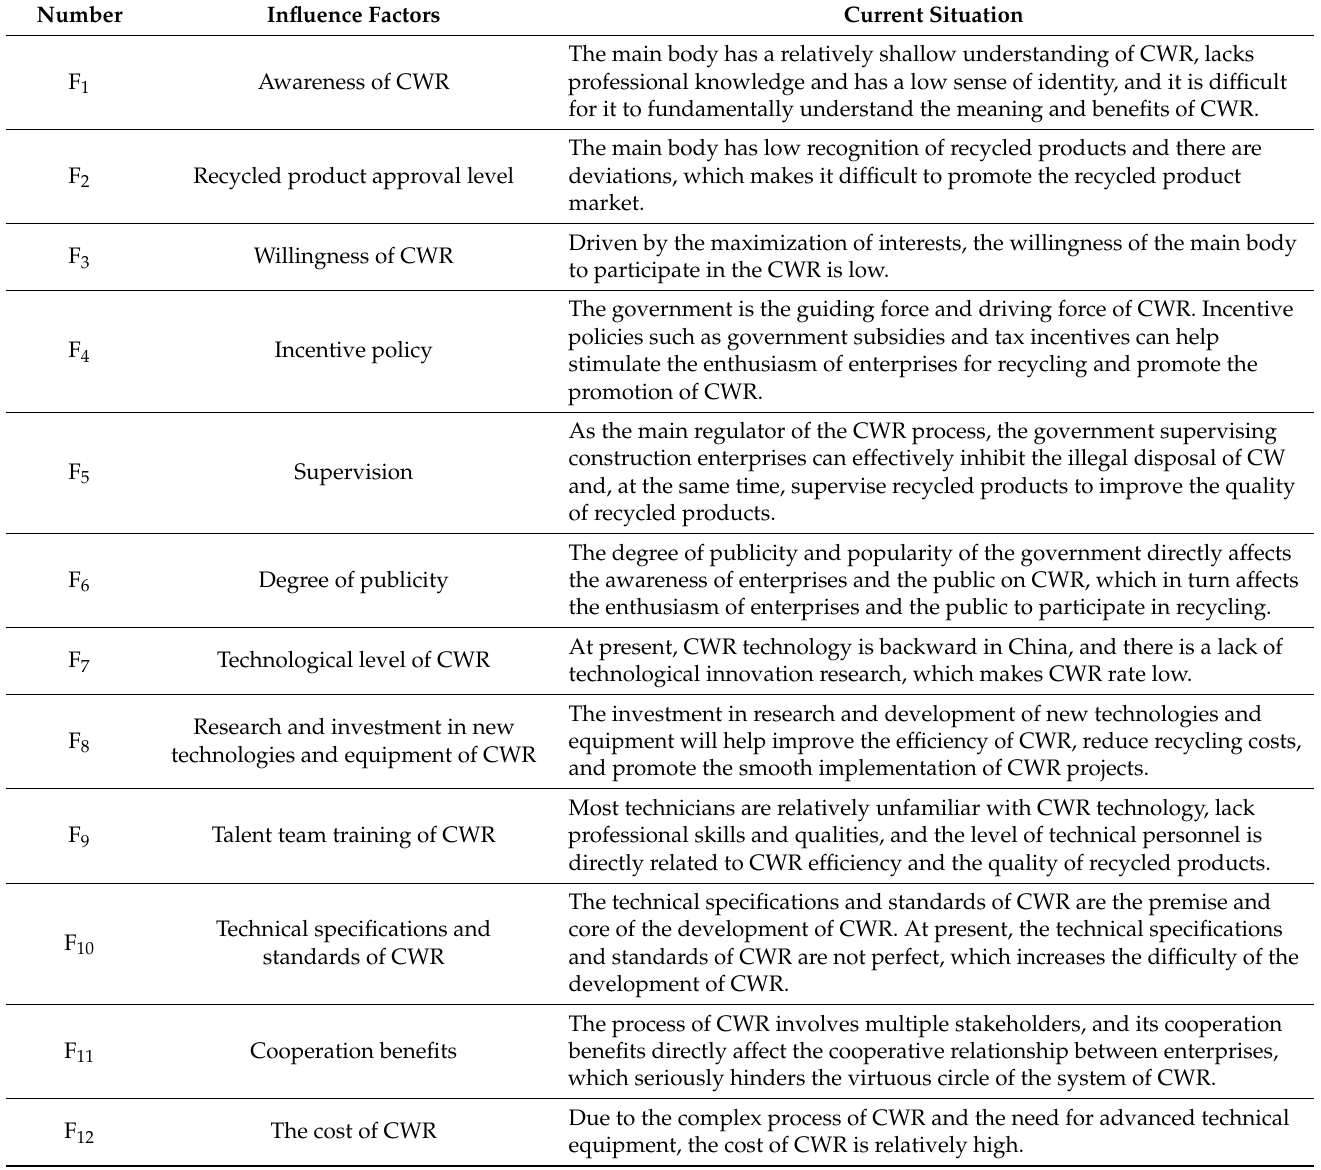
Table 2. List of influence factors of